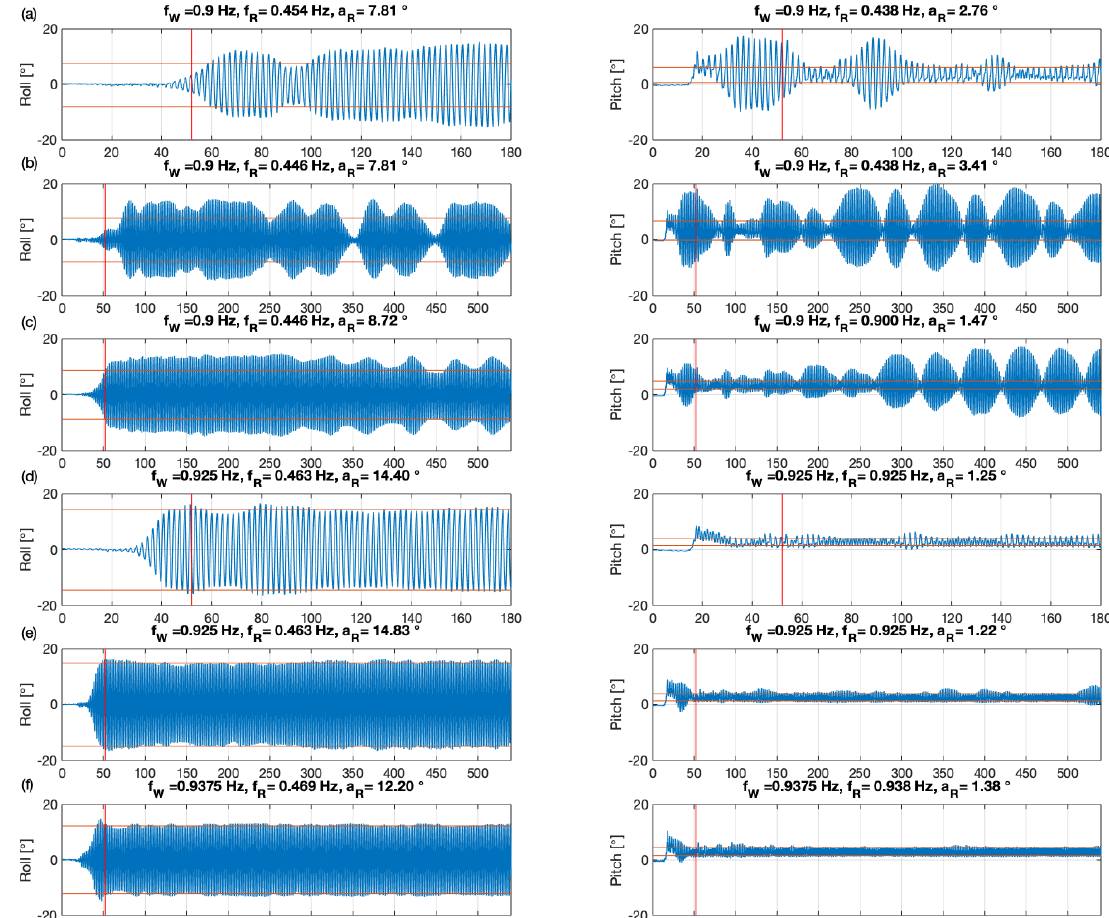
Figure 8. Sample time series of roll and pitch for six test runs with different requested wave frequency f W and expanded capture time—( a ) f W = 0.90 Hz, 180 s, ( b , c ) 0.90 Hz, 512 s, ( d ) 0.925 Hz, 180 s, ( e ) 0.925 Hz, 512 s, ( f ) 0.9375 Hz, 512 s—vertical red line indicates the 52 s rump-up time. The horizontal red lines mark the response amplitude ± a R and the connected response frequency f R is provided in the title of the individual